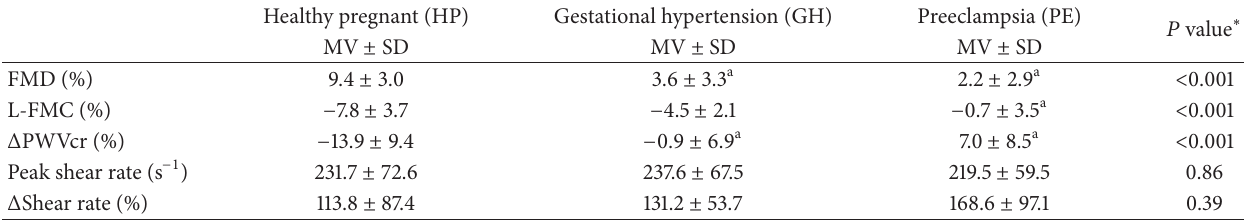
Table 3: VRT-related changes in vascular parameters of the study groups according to pregnancy